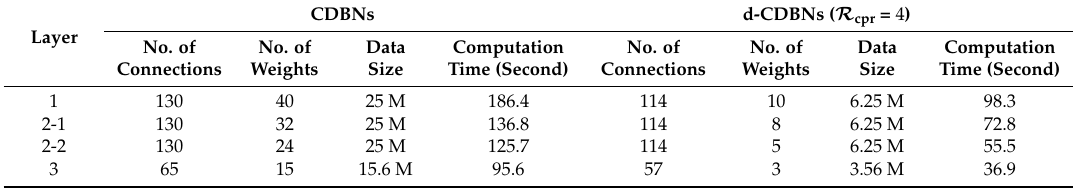
Table 8. Comparison of performance between CDBNs and d-CDBNs for university scene.